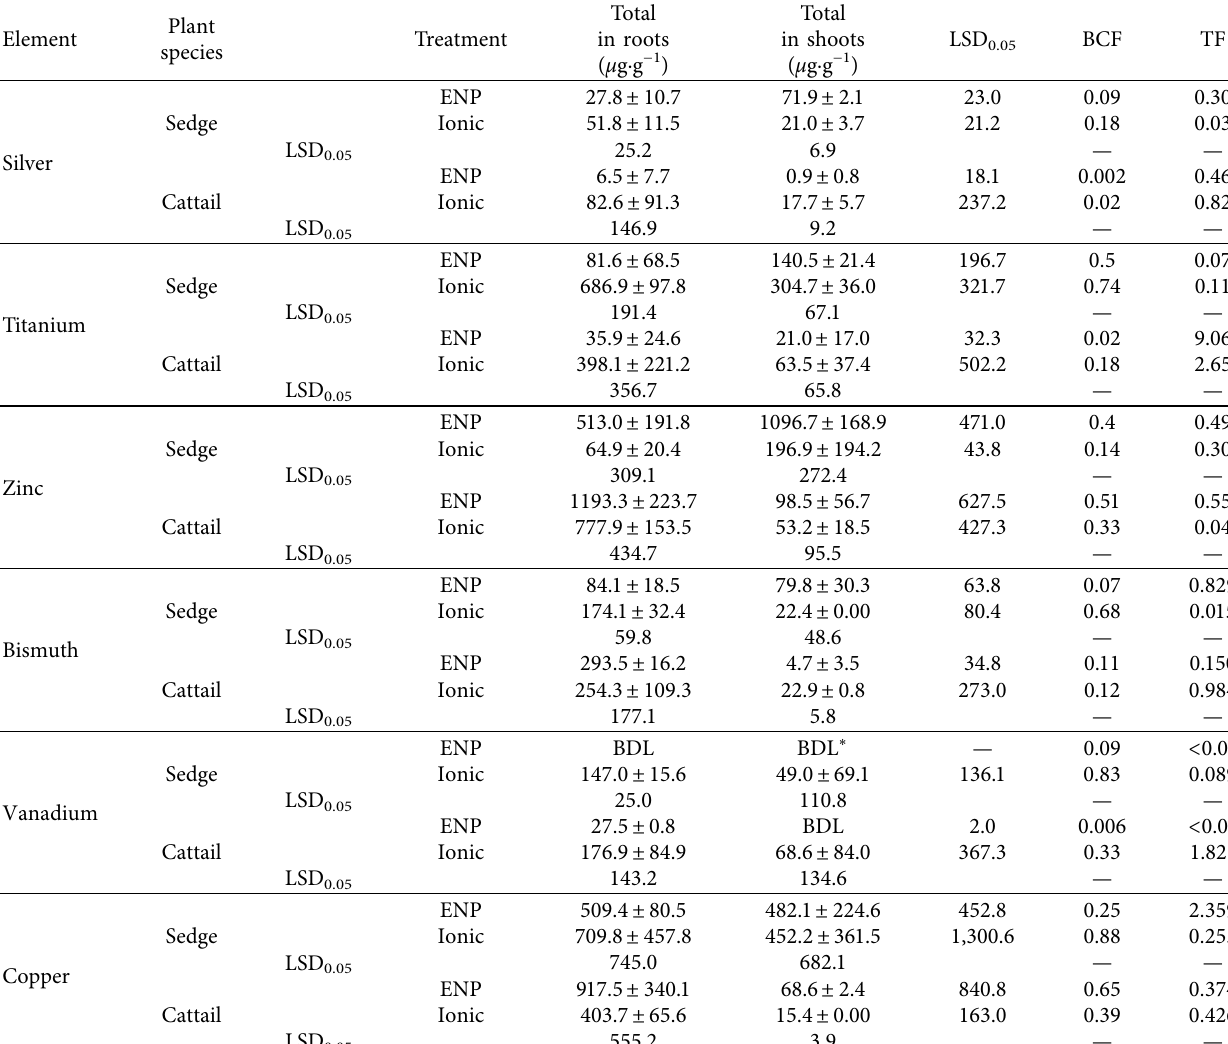
Table 3: Metal uptake from exogenously applied ENPs and ionic metal by sedge and